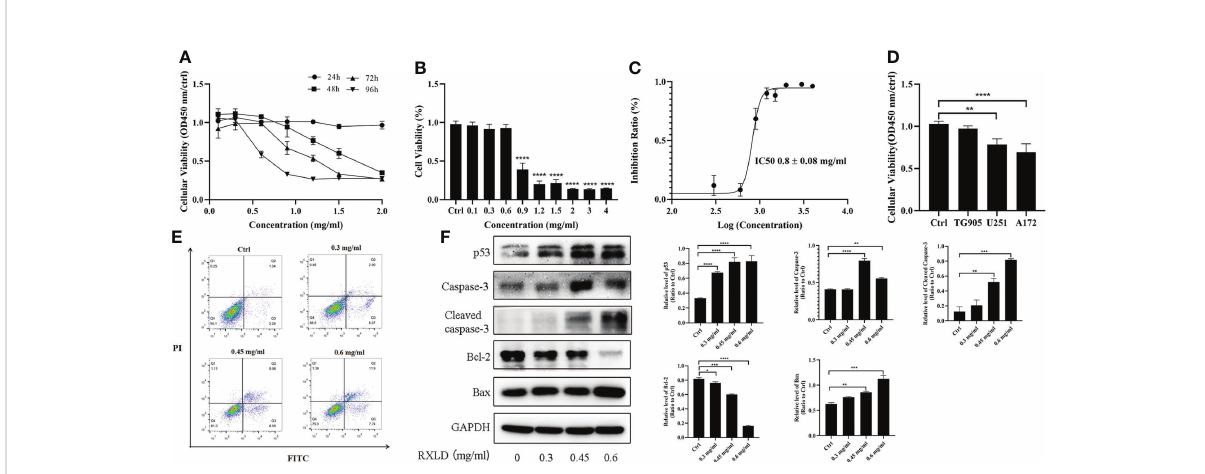
FIGURE 7 RXLD extracts inhibited GBM cell proliferation and induced apoptosis. (A) Cell viability of the A172 glioma cells after treatment with difference concentrations of RXLD extracts for 24, 48, 72, and 96 h; (B, C) Cell viability of the A172 glioma cells after treatment with difference concentrations of RXLD extracts for 48 h; (D) Cell viability of the A172, TG905, and U251 cell lines after incubation with RXLD extracts (0.8 mg/ ml); (E) RXLD extracts with different concentrations can induce apoptosis in the A172 cell line; (F) RXLD extracts with different concentrations